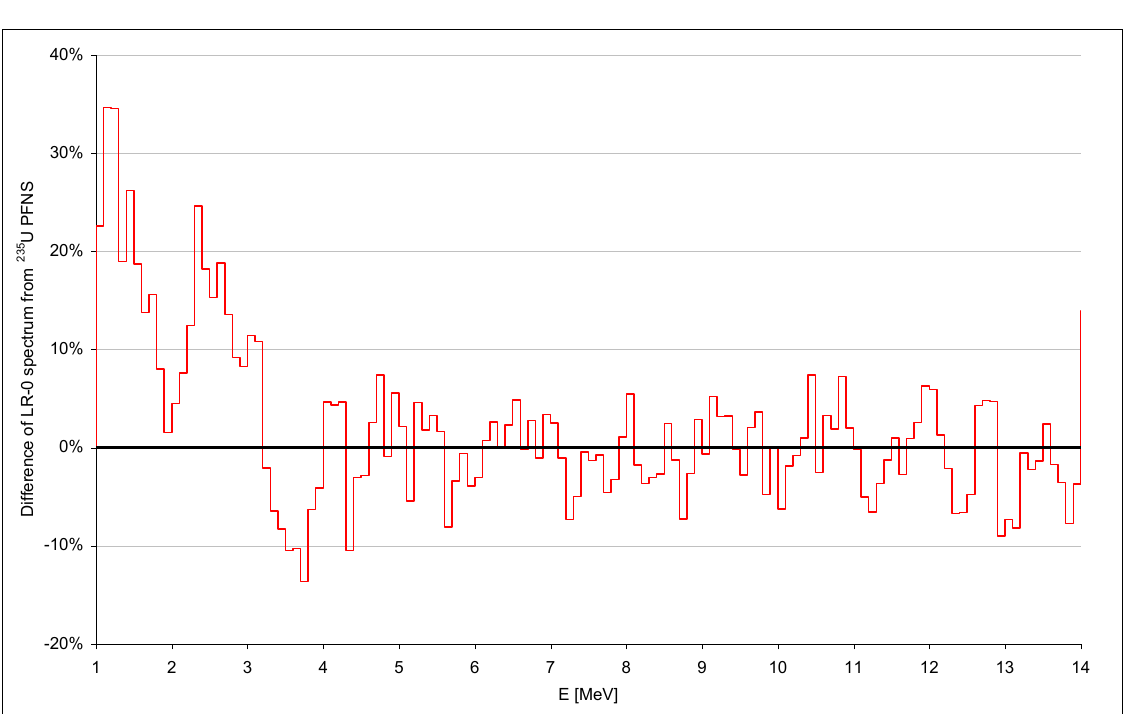
Figure 4. Difference between calculated reactor spectrum and scaled 235 U fission spectrum Table III. Experimentally determined averaged cross sections scaled to 235 U fission